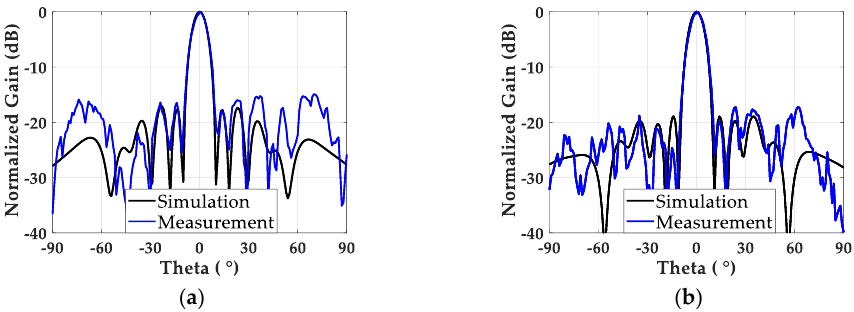
Figure 13. Normalized simulation and measurement gain of ( a ) the non-uniformly powered and uniformly spaced antenna array, and ( b ) the non-uniformly powered and spaced antenna array.